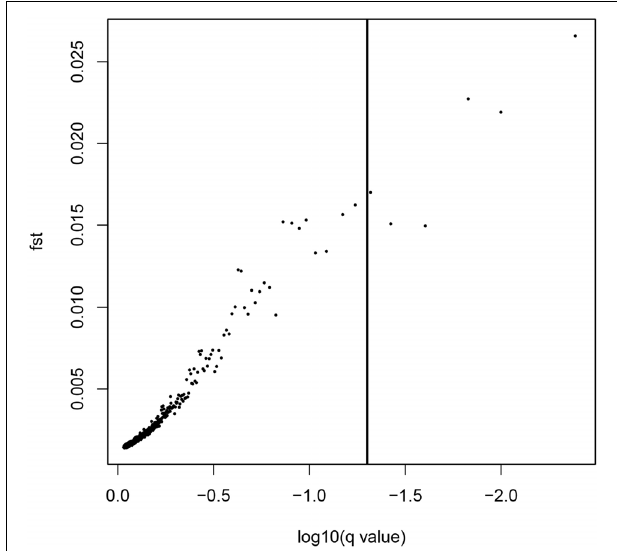
FIGURE 4 | Results from the Bayescan F ST outlier analysis for 28,782 SNPs (black dots). Six SNPs on the right side of the vertical line are above a 0.95 probability for being candidates of